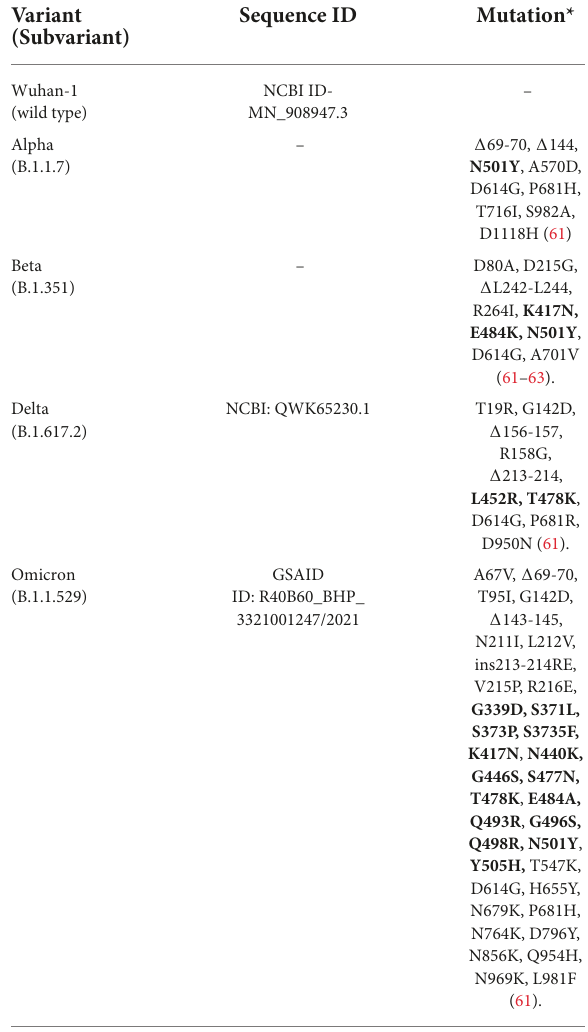
TABLE 1 Spike gene mutations in the beta, delta, and Omicron